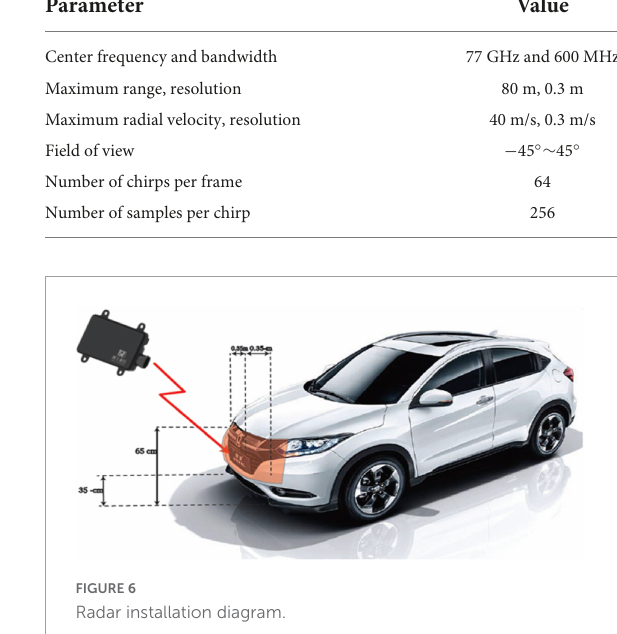
TABLE 1 The specific configurations of radar.